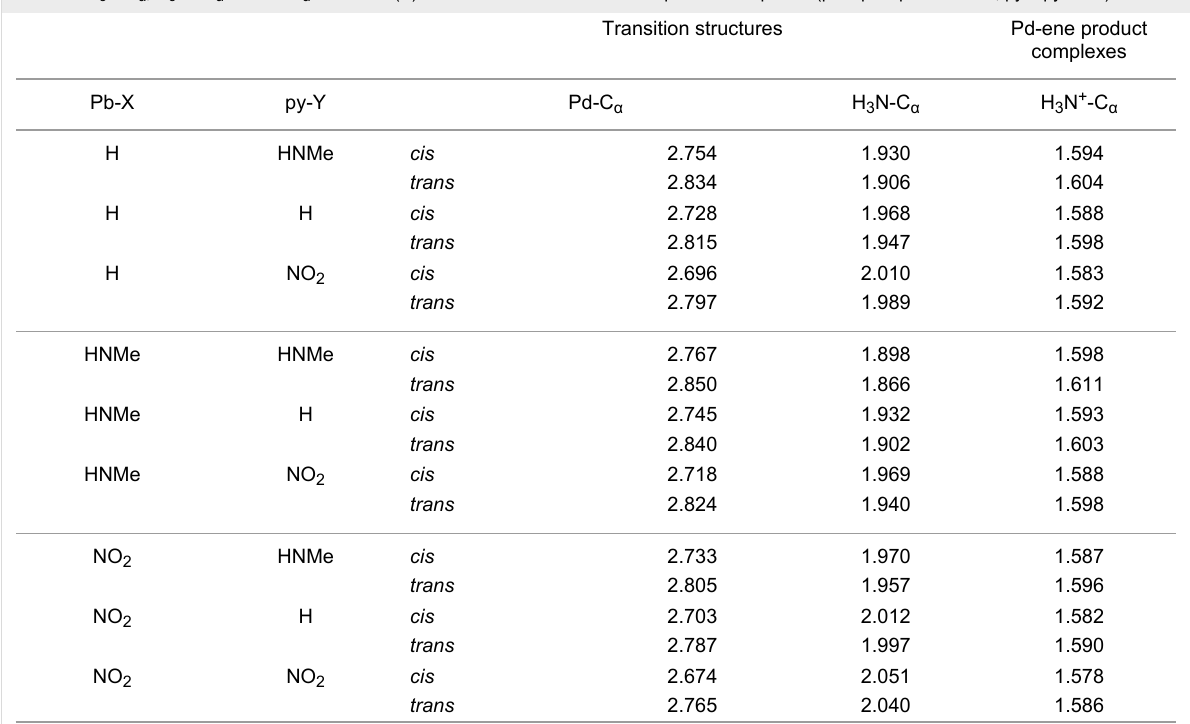
Table 2: H 3 N-C α , H 3 N + -C α and Pd-C α distances (Å) of transition states and Pd-ene product complexes (pb = phosphabenzene; py = pyridine)